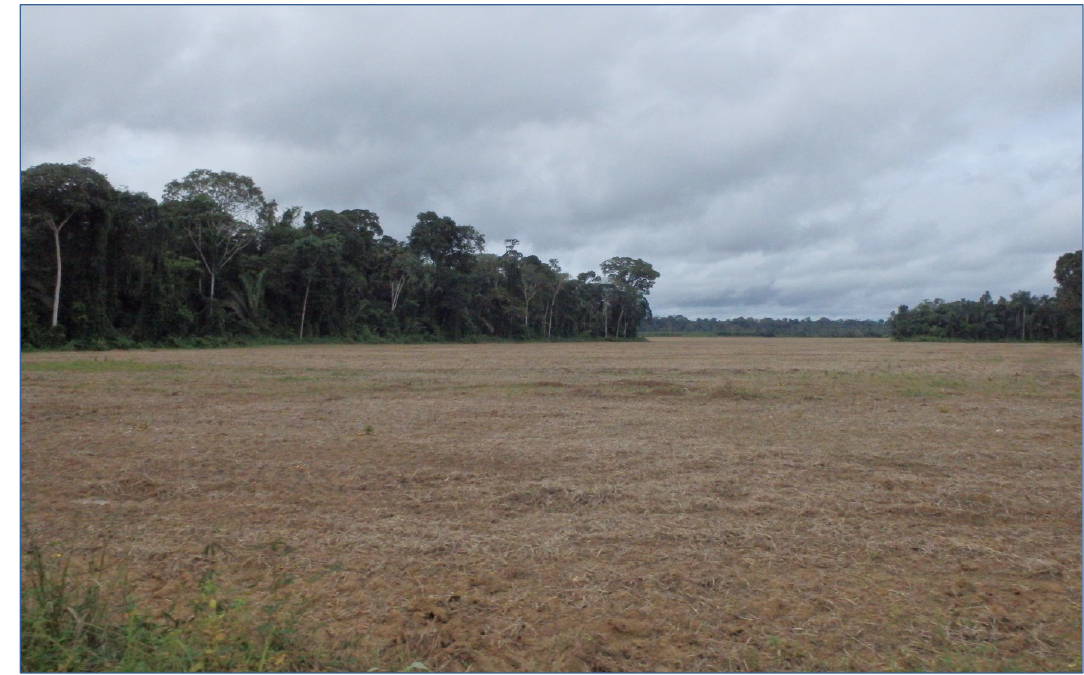
Figure 1: Soy fields near Santarém in the Brazilian Amazon (photographed by author) I suddenly had one more day in Belém. I heard a taxi driver talking French at a hotel. ‘Where did you learn that?’ I asked. ‘By practising’, he replied. He explained that he regularly had French customers, some from nearby French Guiana, to buy timber. ‘So you know the timber businesses here?’ I asked. ‘I know them all!’, he replied. I asked his price and booked him for the next day. The next morning we left the city and he gave an overview of timber companies operating locally. I chose one nearby to visit first. Arriving at a big gate, the driver said that timber companies were not easily accessible ‘but they know me!’. I thought that it was better to use a cover. 4 I pretended to be interested in timber, which he translated at the gate. Inside, the director appeared to be Dutch, which completely took me by